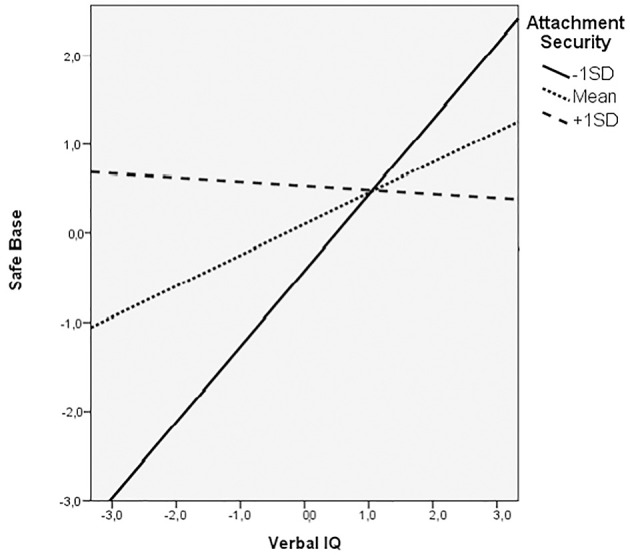
Plot of slopes of Relations between Teacher–Child Relationships and Verbal IQ for Three Levels of Attachment Security.